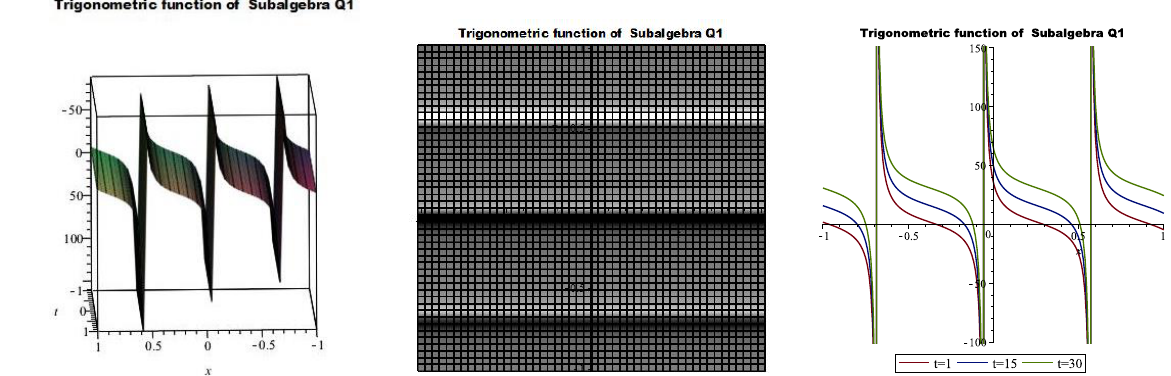
Figure 1. Solitary wave depiction of singular periodic solution (34) at y = 0.